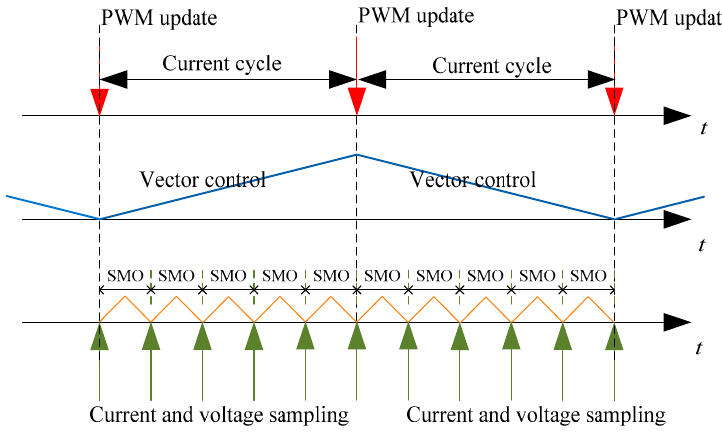
Figure 6. Typical sequential of PWM update and SMO sampling.